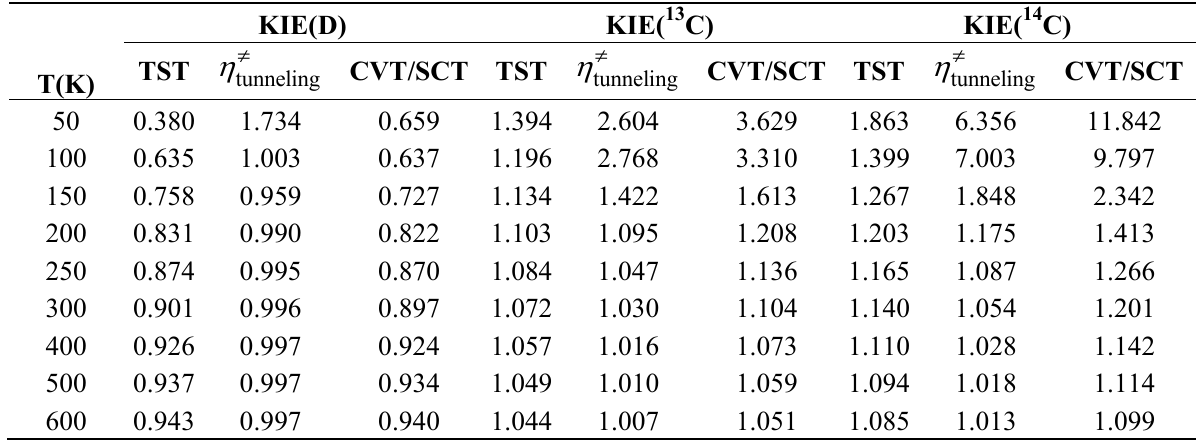
Table 9. Calculated KIEs and its tunneling contributions by the TST and CVT/SCT theory.